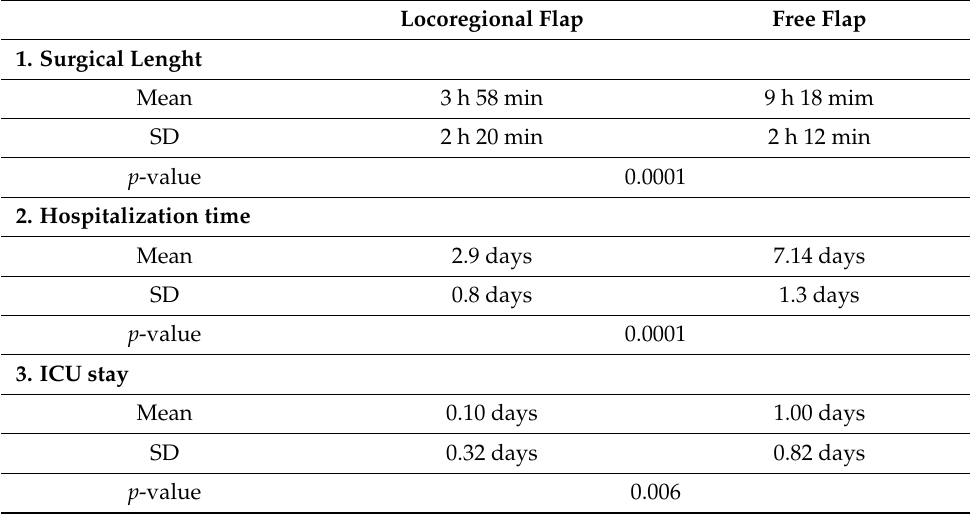
Table 2. Surgical length, hospitalization time (days), intensive care unit stay